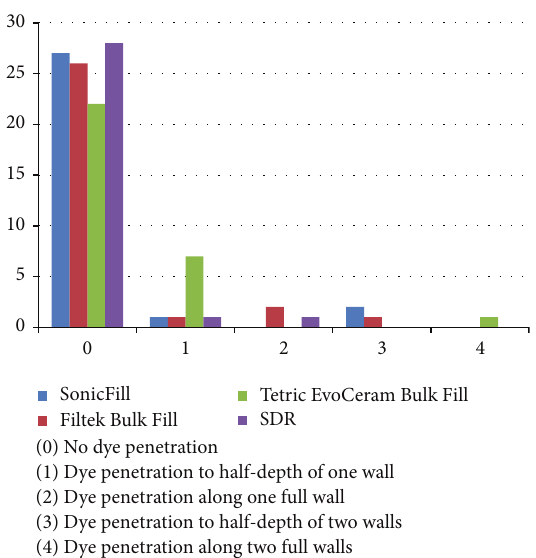
Figure 5: Dye penetration along examined